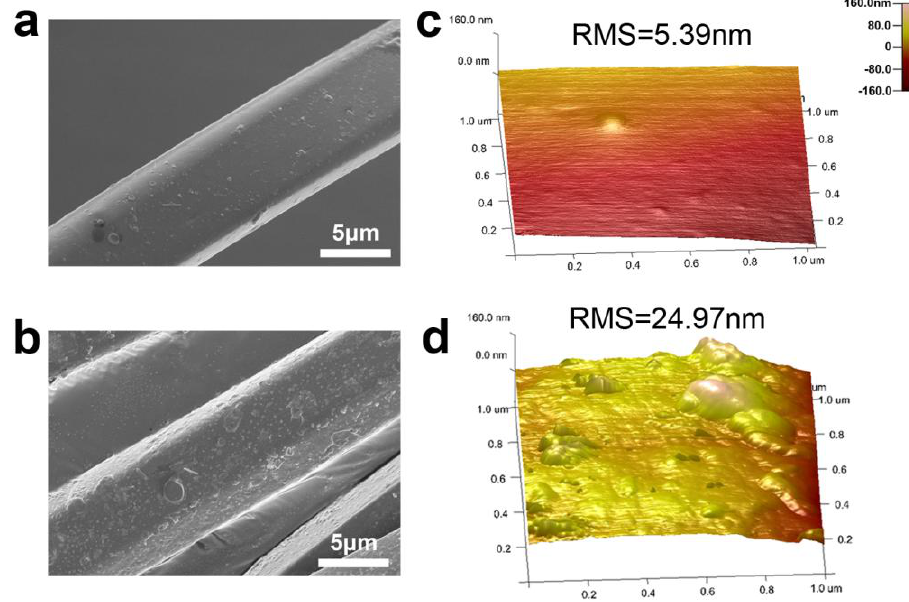
Figure 6. SEM characterization of samples: ( a ) untreated yarn; ( b ) optimal yarn. AFM characterization of samples: ( c ) untreated yarn; ( d ) optimal yarn.